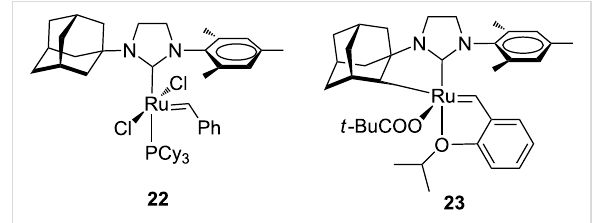
Figure 6: A Grubbs-type complex with an N -adamantyl, N ’-mesityl NHC 22 and the Hoveyda-type complex with a chelating N -adamantyl, N ’-mesityl NHC 23 .